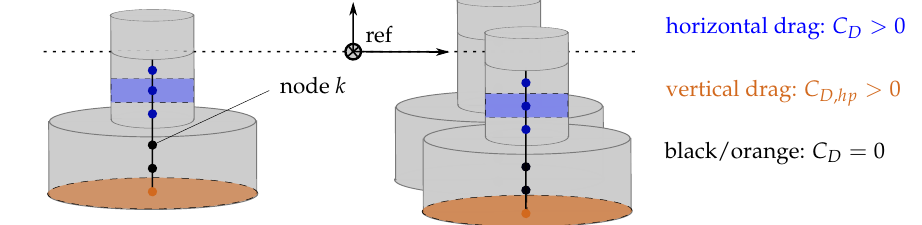
Figure 2. Discretized platform shape with nodes of horizontal and vertical drag coefficients. In this work, horizontal drag forces are only applied to the column nodes (dark blue) and vertical drag forces are only applied to the heave plate nodes (light